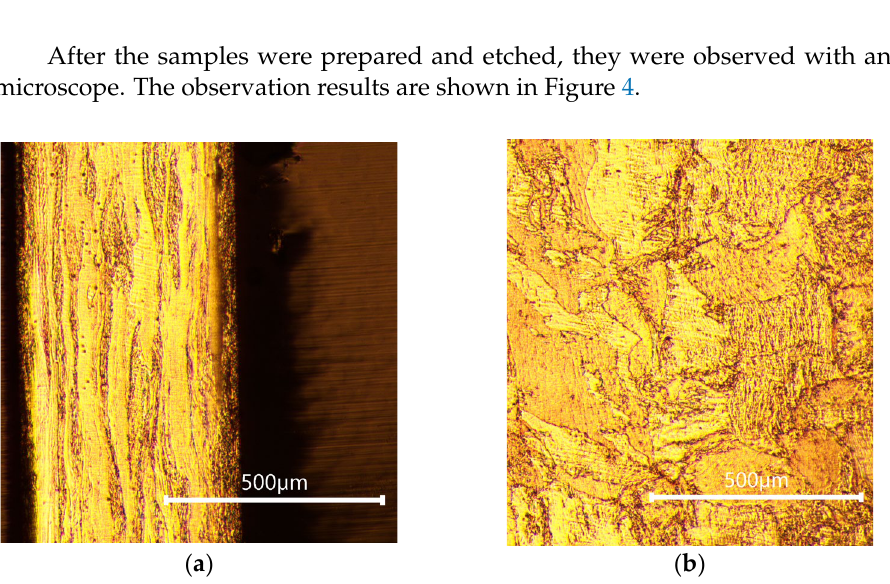
Figure 4. Optical micrograph showing the microstructure of the starting material: direction of rolling ( a ) perpendicular; ( b ) in parallel with the viewing plane.